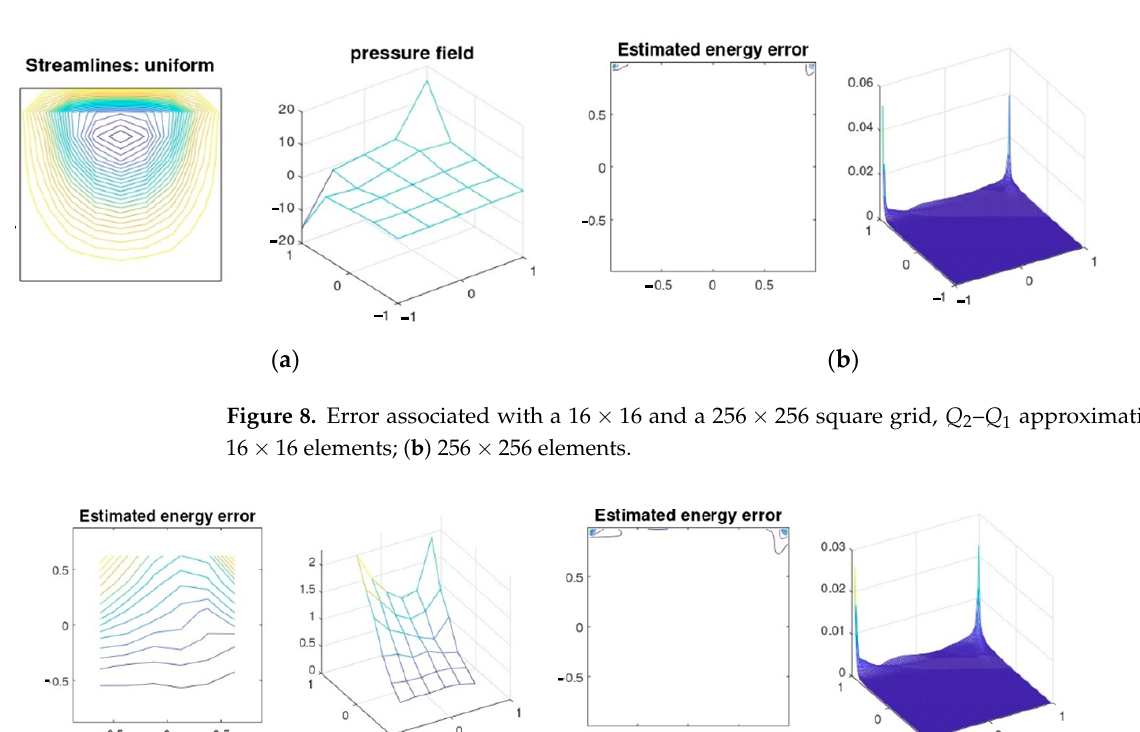
Figure 7. Error associated with a 16 × 16 and a 256 × 256 square grid, 𝑄 (cid:2869) – 𝑃 (cid:2868) approximation. ( a ) 16 × 16 elements; ( b ) 256 × 256 elements.